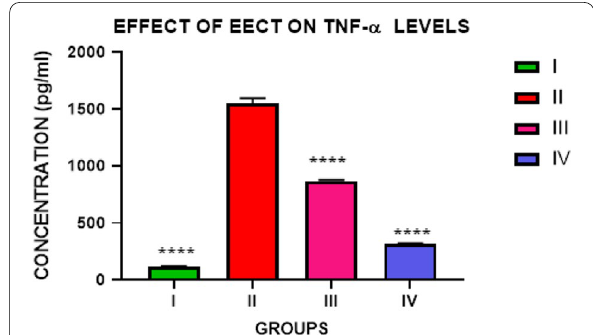
Fig. 4 Effect of EECT on TNFα Levels